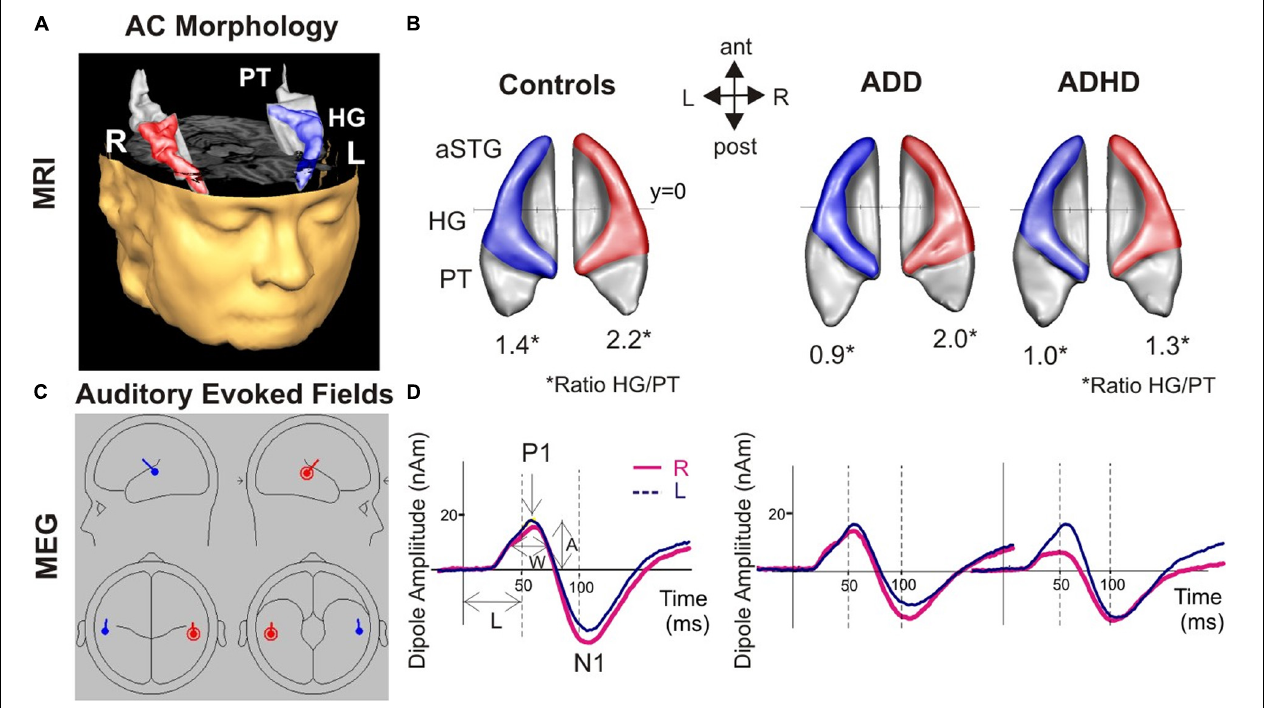
FIGURE 1 | Morphological and functional brain-based correlates for AD(H)D. (A) 3D reconstruction of an individual auditory cortex (AC); Heschl’s gyrus (HG), and anterior superior gyrus (aSTG) are colored in blue (left) and red (right), respectively. The planum temporale (PT) and planum polare (anterior to first transverse sulcus) are displayed in gray. (B) Top view of group-averaged auditory cortices (L, left; R, right, ant, anterior; post, posterior). The mean ratios of HG/PT gray matter volumes (marked by asterisks “*” indicates the HG/PT ratio) are indicated by numbers. All disorder subgroups (ADHD and ADD) showed downsized left HGs resulting in a diminished left HG/PT. Further, ADHD patients had smaller right HGs and consequently a lower right HG/PT. In contrast, ADD subjects showed no right-hemispheric differences. (C) Overview of the MEG dipole localization in the left (blue) and the right hemisphere (red). Group-averaged source waveforms of the P1-N1 complex in response to various sounds for the right (red) and left (blue) hemisphere. (D) ADD subjects showed, similar to controls, a well-balanced hemispheric response pattern, ADHD patients a left-right asynchrony with a preceding response in the right